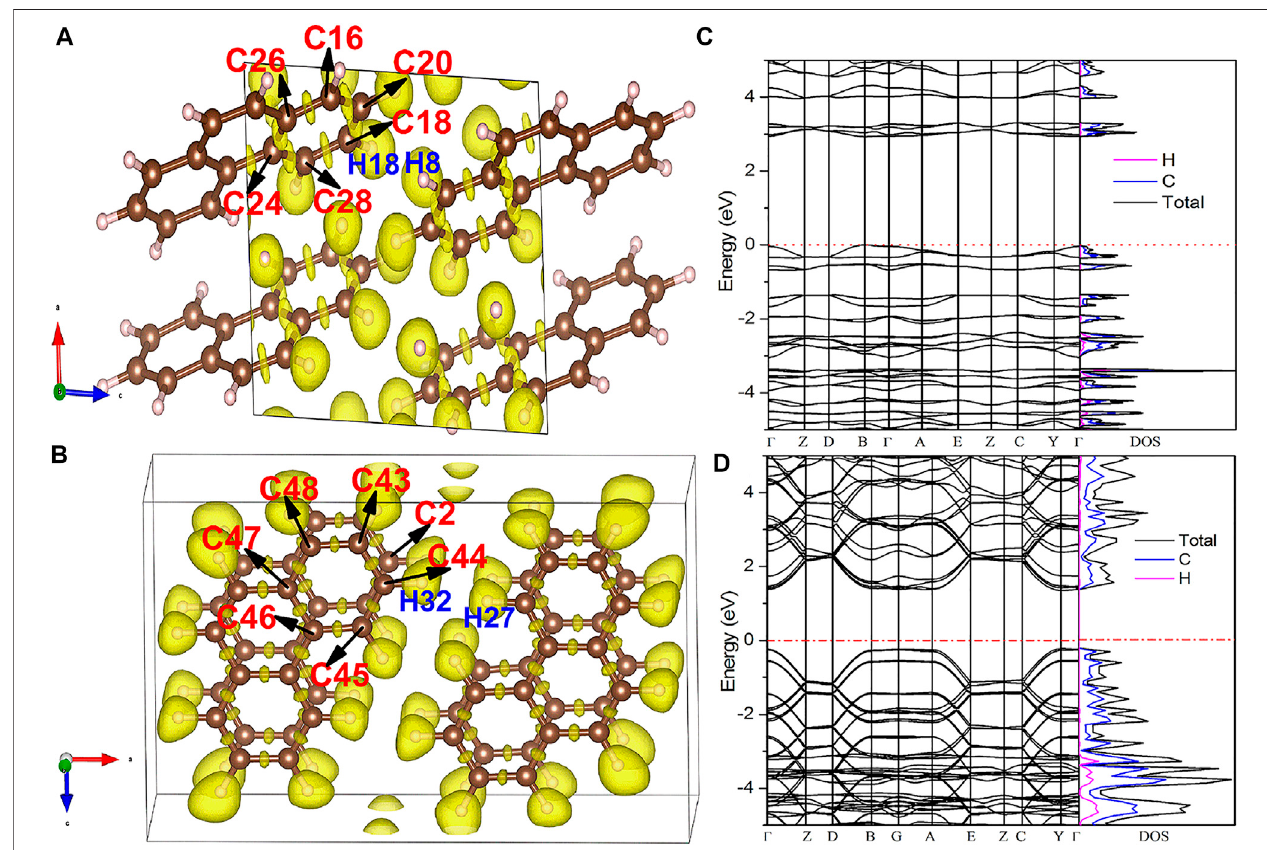
FIGURE 8 | Electronic properties of Phase I and Phase II in phenanthrene at 0.5 and 4 GPa. Electron localization function (ELF) (A, B) , band structure (left) , and Partial DOSs (right) (C, D) .